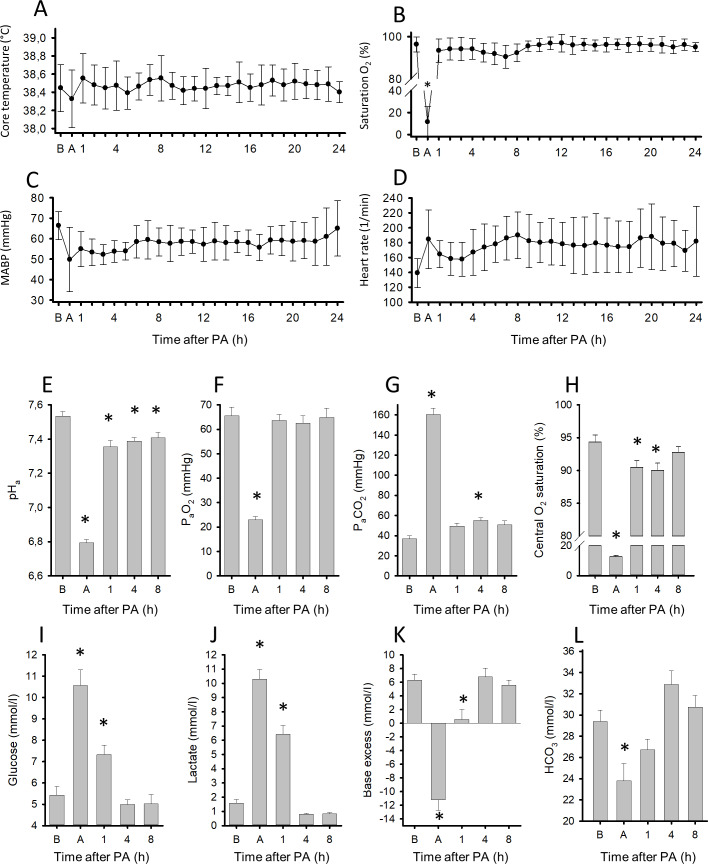
Physiological parameters and blood chemistry changes during PA and the subsequent 24h reventilation period.Core temperature of the animals (n = 13) was maintained in the physiologic range (38.5±0.5°C) during the whole experiment (A). Blood oxygen saturation by pulsoxymetry (B) and mean arterial blood pressure (MABP, (C)) returned to baseline levels soon after asphyxia, however, the heart rate remained moderately elevated (D). Arterial blood gas analysis revealed that asphyxia resulted in severe acidosis (E), hypoxemia (F), hypercapnia (G), and central (arterial blood) desaturation (H). Plasma glucose (I) and lactate levels (J) were markedly elevated along with large drops in base excess (K) and significant reductions in blood bicarbonate concentrations (L). Reventilation restored most of the deranged parameters by 4 hours, and they were not significantly different from baseline levels afterwards, except for pH that was restored to the normal values [23] and not to the slightly alkalotic baseline. B: baseline, A: at the end of 20 minute PA. Bars and whiskers represent mean±SEM, *p<0.05 vs. baseline values.